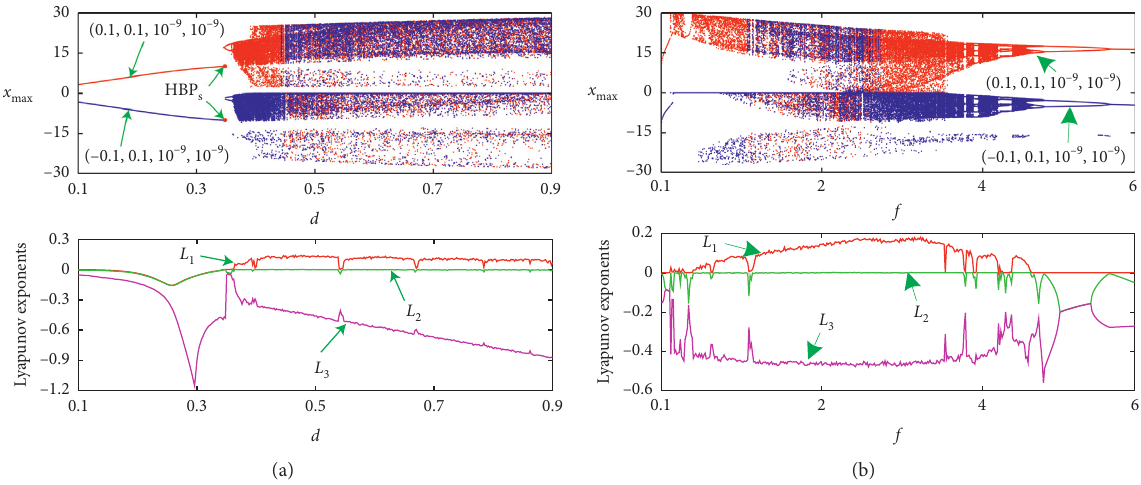
Figure 4: Numerically simulated 1D bifurcation plots of the maxima of the variable x and finite-time Lyapunov exponents with respect to d and f , respectively. (a) The parameter d varying with f � 1.88. (b) The parameter f varying with d �